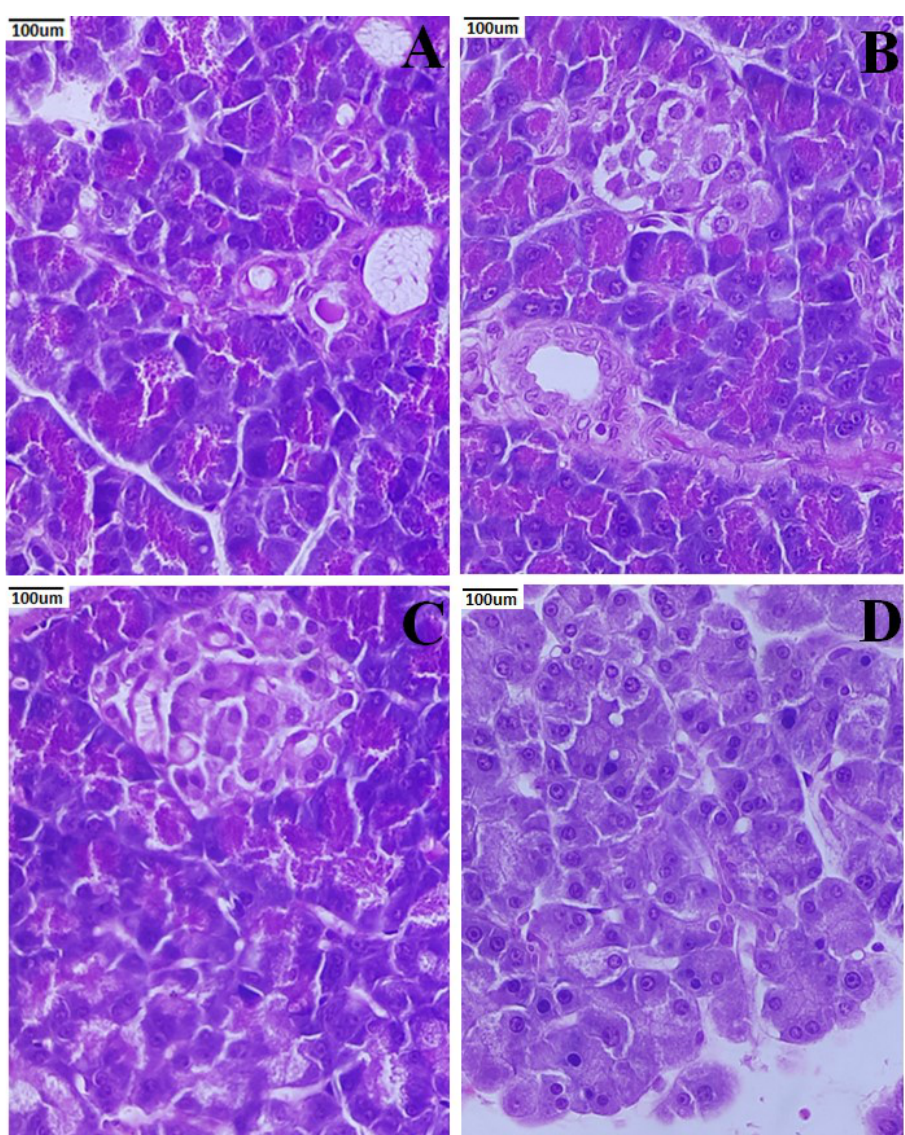
Figure 8. Activities of PCNPs on the pancreatic histopathological picture of DN rats (40×). ( A ) Normal photomicrographic pancreas with islet cells surrounded by acini; ( B ) DN rat showing atrophic pancreatic acini with fatty infiltration; ( C ) STZ + 80 mg/kg of PCNP-treated pancreas shows the regeneration of islet cells with few atrophic acini; ( D ) 80 mg/kg of PCNP only shows the normal architecture of pancreatic cells.